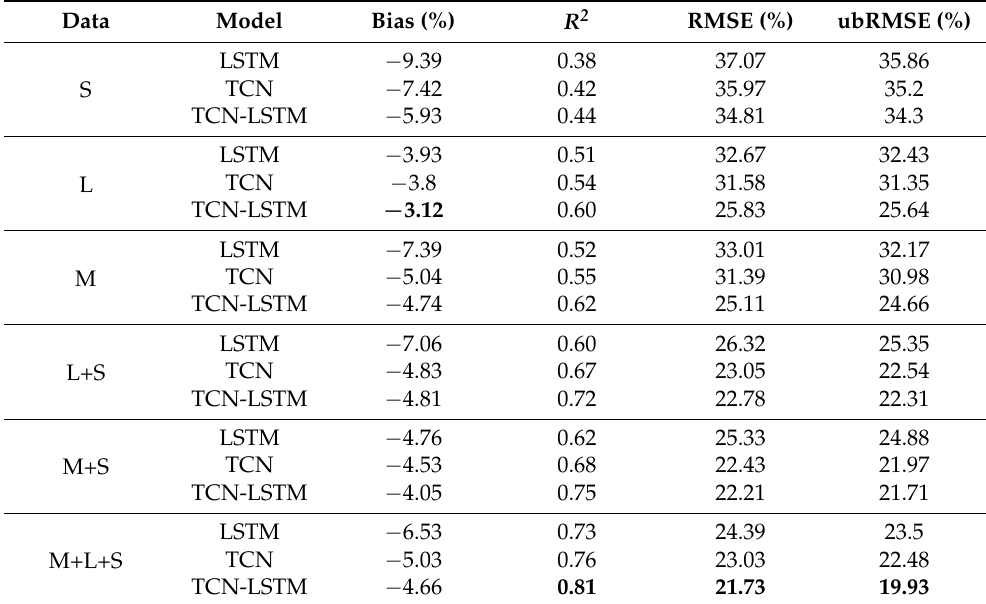
Table 3. Evaluation results of LFMC retrieval results based on LSTM, TCN and TCN-LSTM.